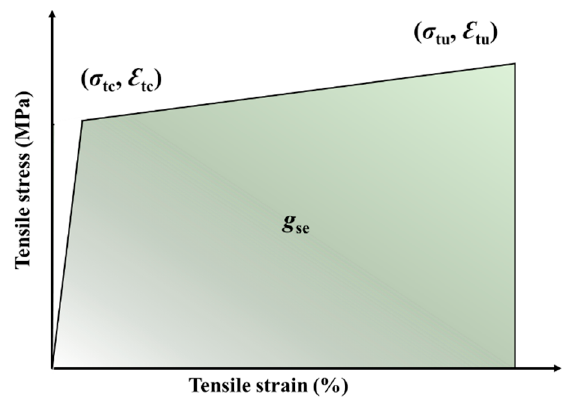
Figure 11. Bilinear model for the tensile stress-strain curve of ECC.